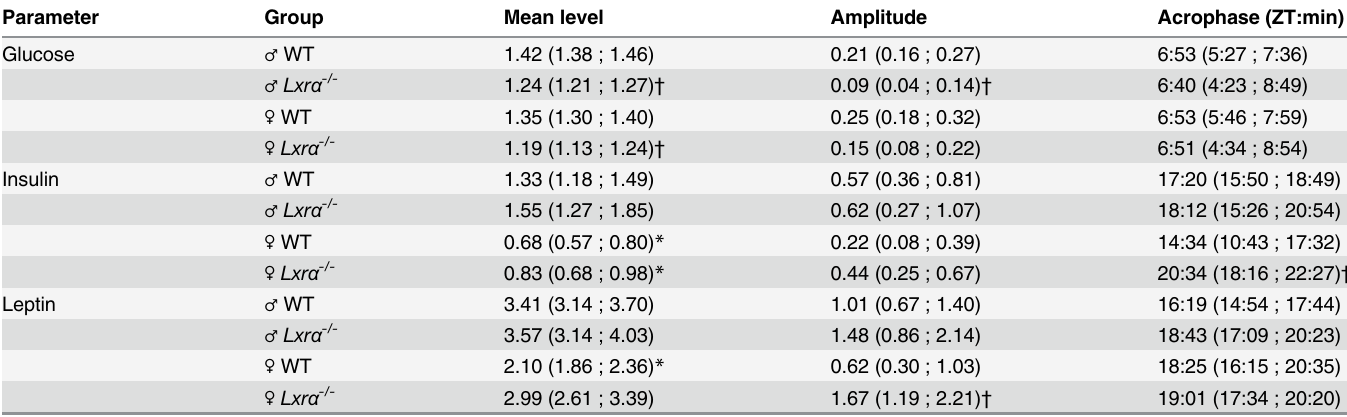
For each parameter measured, values are represented as median ± 95% bootstrap con fi dence intervals. * indicates signi fi cant differences between females vs males † indicates signi fi cant differences between Lxr α -/- vs WT mice. Circadian rhythmicity was considered signi fi cant for a p -value < 0.05; NSR, not signi fi cantly